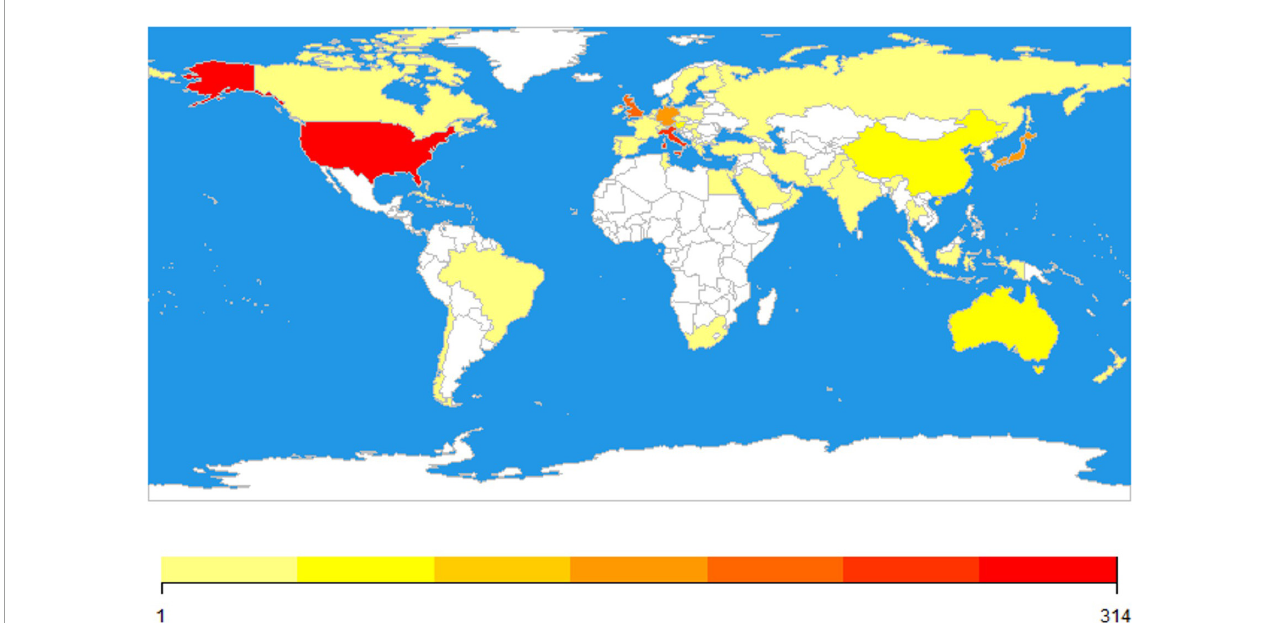
FIGURE5 The world map of active countries. Color represented the number of publications. White represented no publication, while from yellow to red illustrated the number of articles. The number of over 314 articles was uniformly expressed in dark red.